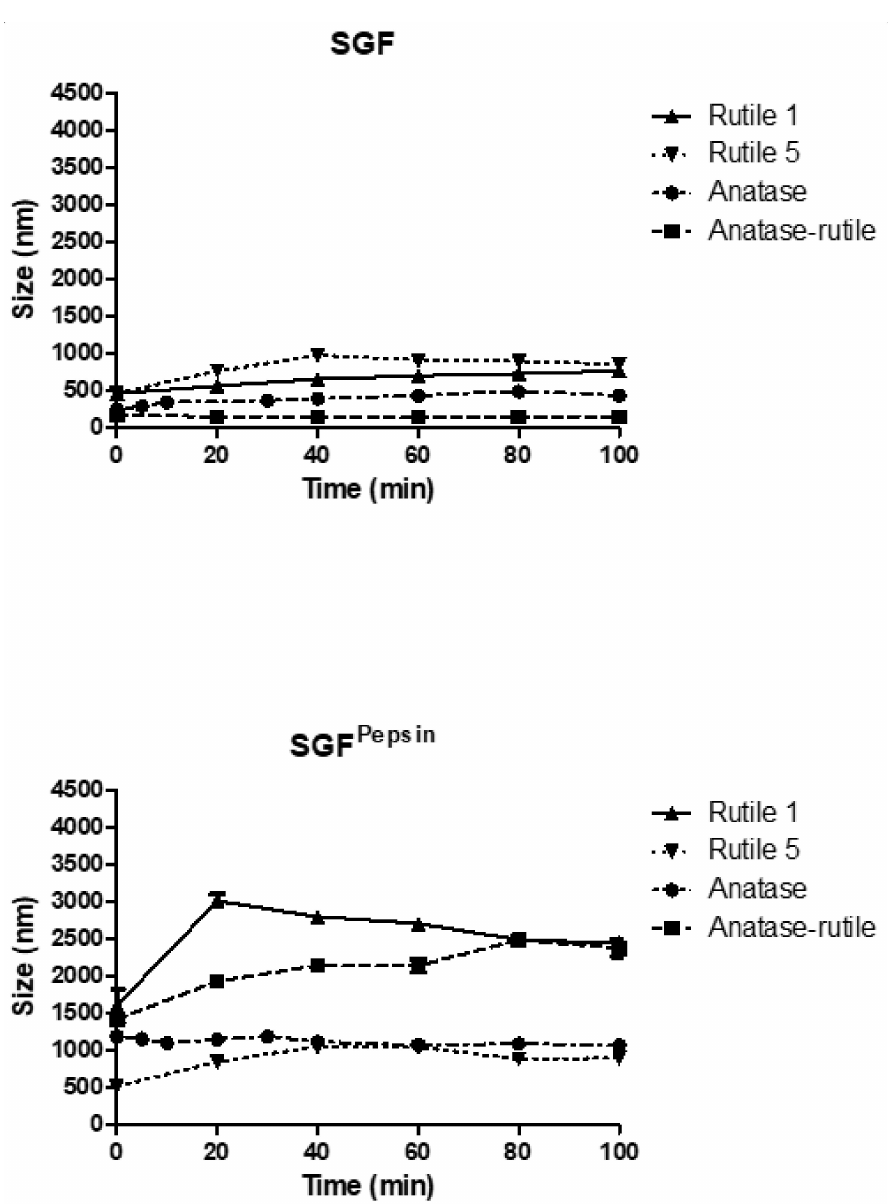
Figure 5. Time-dependent change in particle size of TiO 2 particles in simulated gastric fluids. The starting concentration of the TiO 2 particles was 0.5 mg/mL dispersion